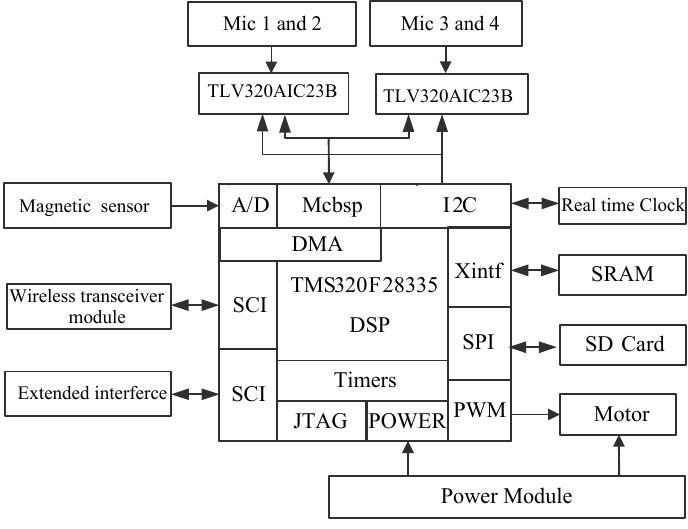
Figure 11. Schematic architecture of DSP system.